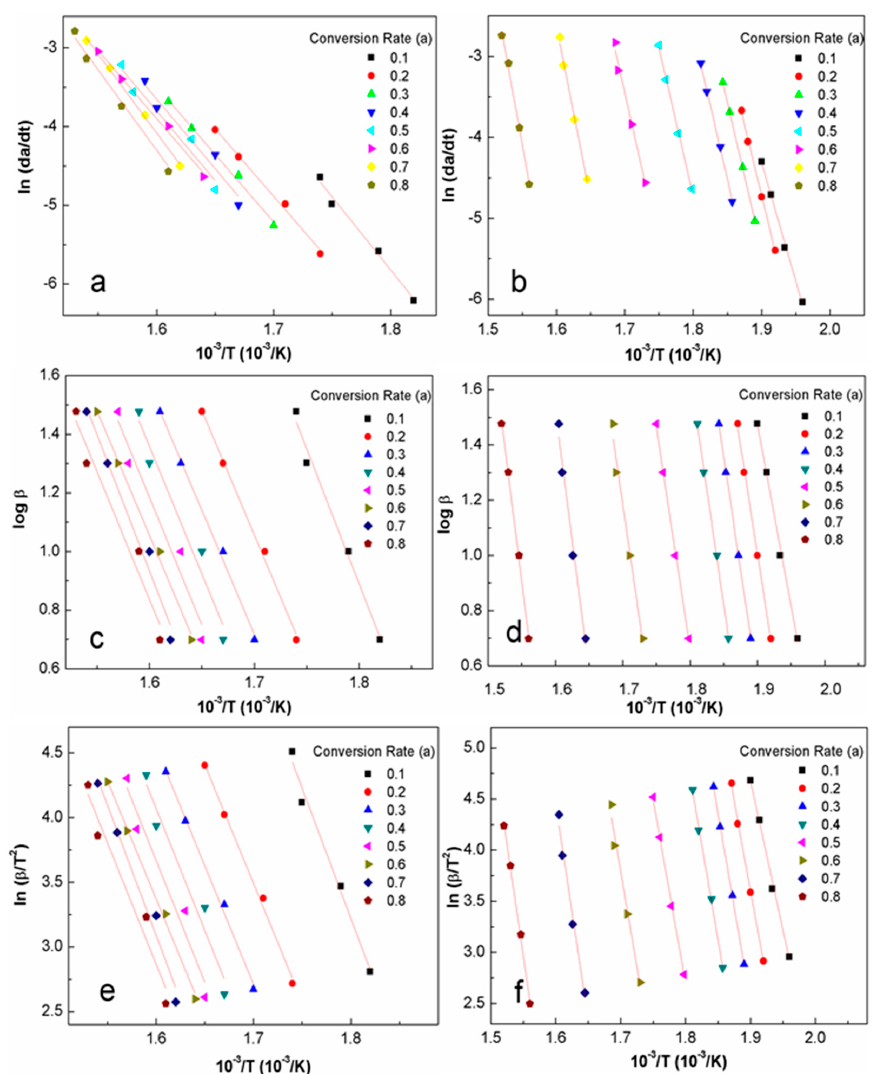
Figure 6. Typical iso-conversion plot for the cellulose and the CNCs using the ( a , b ) Friedman method; ( c , d ) Flynn-Wall-Ozawa method; and ( e , f ) Coats-Redfern method.